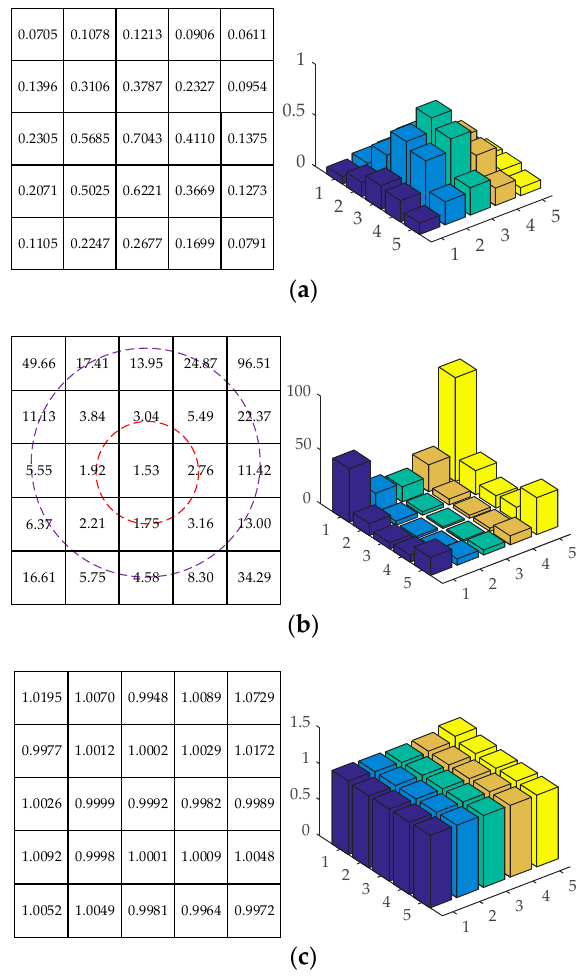
Figure 1. The intensity I , weights w and ϕ ( r ) of a star spot. ( a ) is the intensity of the star spot; ( b ) is the weights w in Equation (8) of the star spot; ( c ) is the weights ϕ ( r ) in Equation (12) of the star spot. The intensity of the pixels in the center region is greater than that of the pixels in the edge region in ( a ). The weights of pixels in the center region are much less than that of pixels in the edge region in ( b ). All the values in ( c ) are very close to 1.